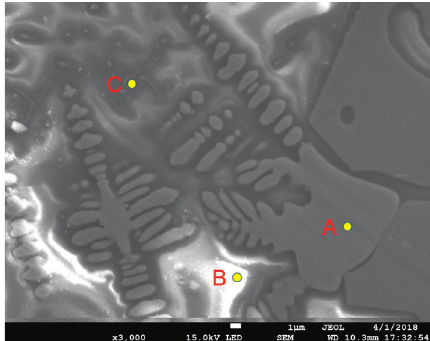
Figure 11: SEM-EDS of the sample with 5% B Table 2: SEM-EDS analysis of the sample with 5.00% B